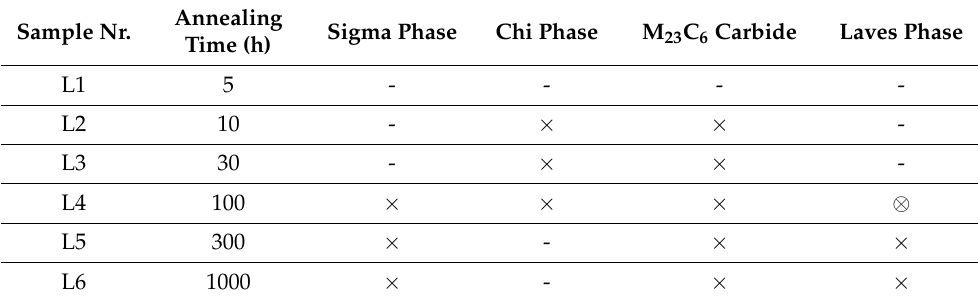
Figure 4. TEM analysis results of carbon extraction replicas of AISI 316L (0% CW): ( a ) 650 ◦ C/5 h of annealing; ( b ) 650 ◦ C/1000 h of annealing. Table 2. Experimentally identified secondary phases in the investigated AISI 316L steel (0% CW) with subsequent annealing at 650 ◦